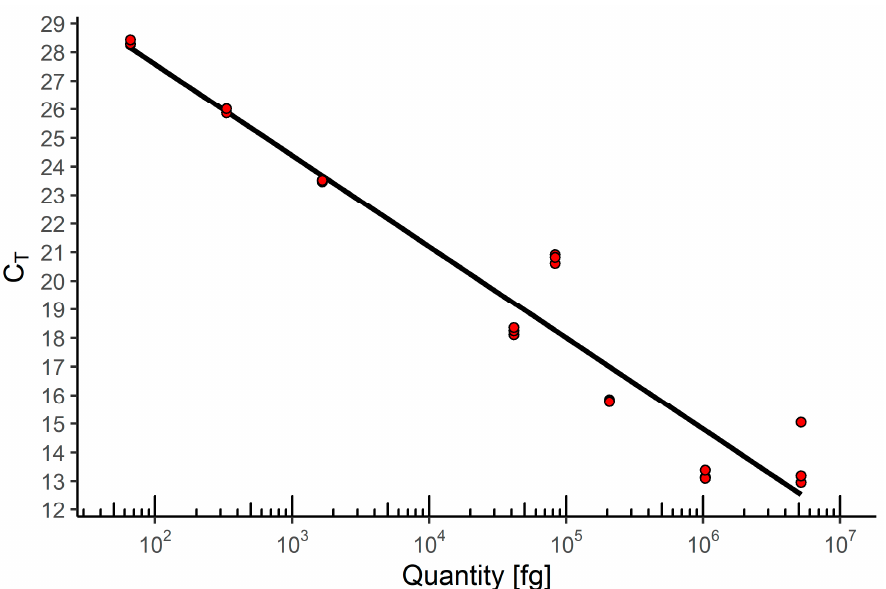
Figure 9. Standard curve for the detection of Meloidogyne luci with primers specific for the Meloidogyne ethiopica group (MEG), with the following parameters: slope: -3.189, intercept (Y): 33.9, R 2 : 0.939, and efficiency (E): 105.863%, showing satisfactory amplification of the template DNA with the selected primers. C T : threshold cycle, DNA quantity in femtograms (fg).